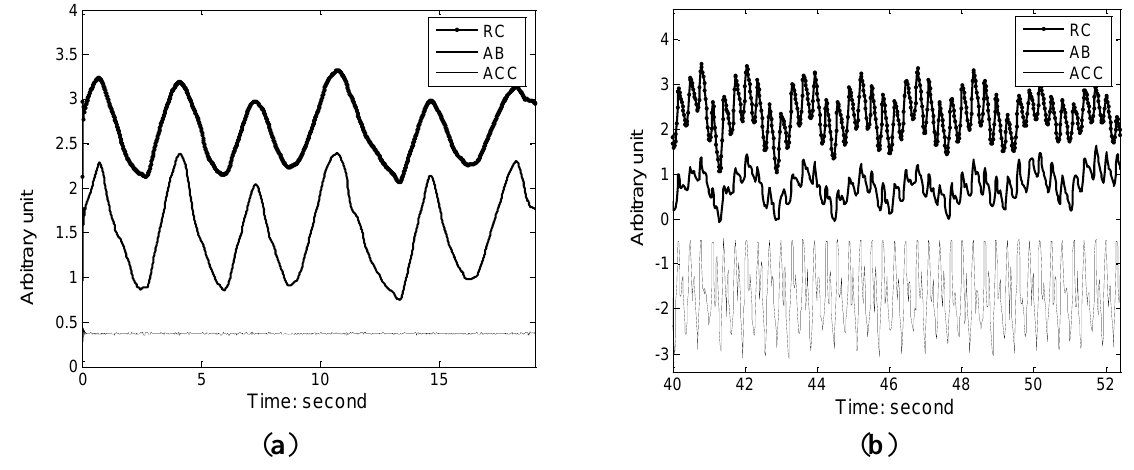
Figure 8. RC and AB respiration and accelerometer reference signal during standing and running. ( a ) respiration during standing; ( b ) respiration during running.